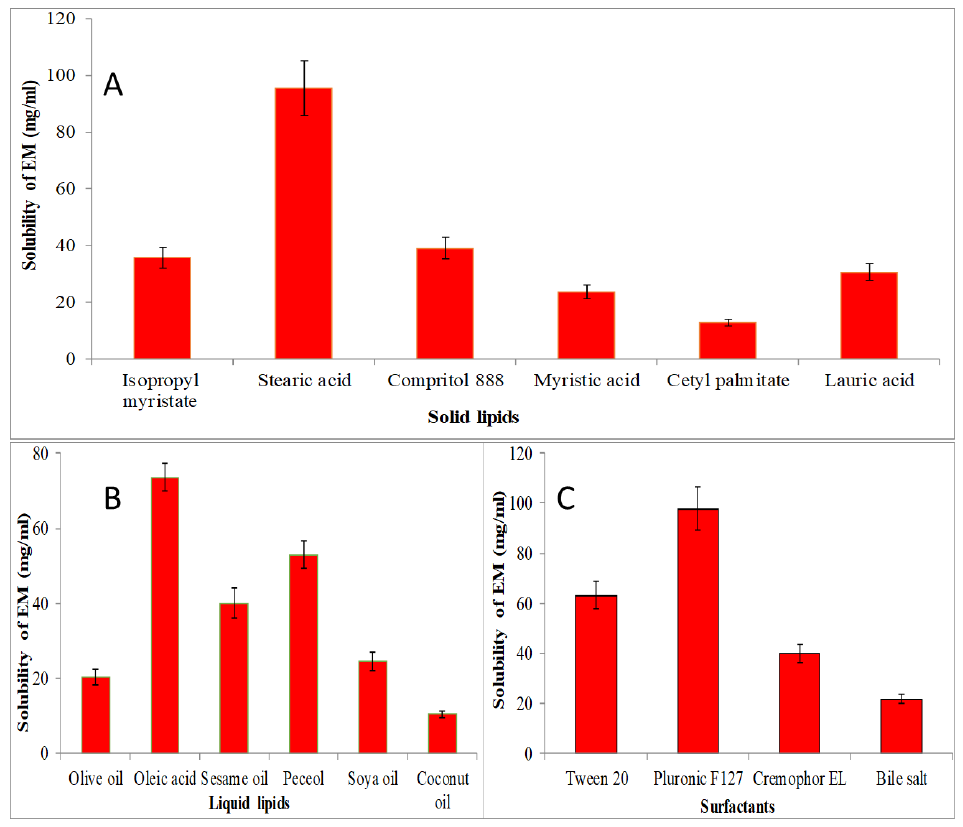
Figure 1. Solubility of EM in various solid lipids ( A ), liquid lipids ( B ), and surfactant ( C ). The study performed in triplicate and data shown as mean ± SD.